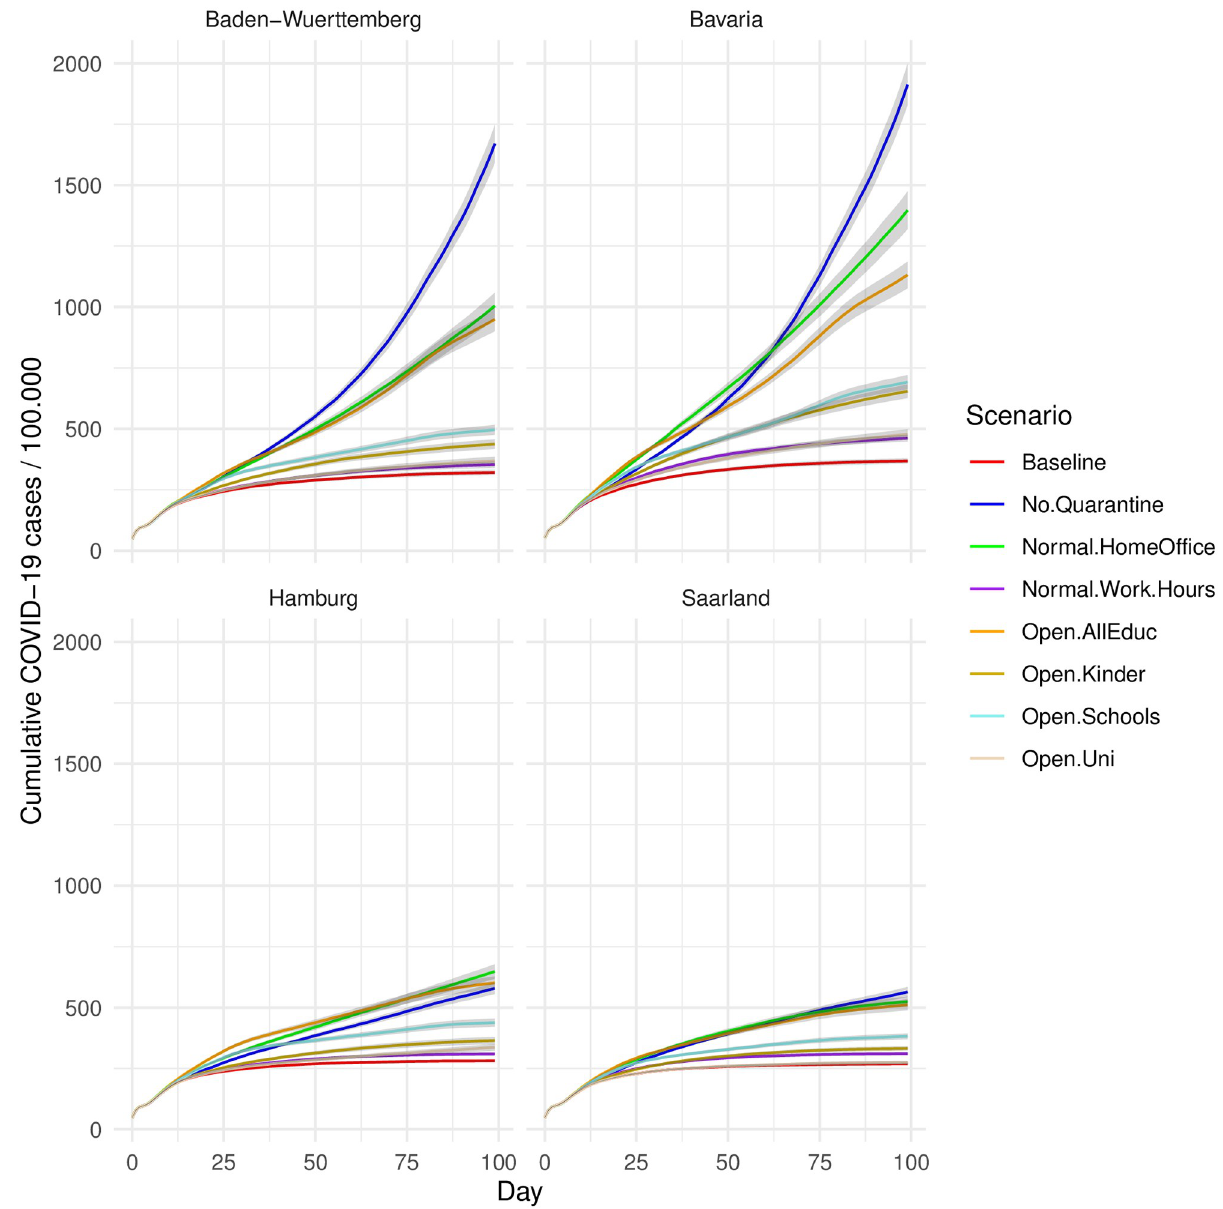
Fig 2. Effect of counterfactual non-implementation of NPIs, by state. Each line represents the average cumulative case numbers per scenario. While all NPIs considered are implemented in the baseline scenario to mimic the real scenario, the lines of the other scenarios show the estimated cumulative case numbers caused by the omission of one or more NPIs. For exact values of the average cumulative case numbers, standard deviations and confidence intervals on day 100, see also S5 and S6 Tables.